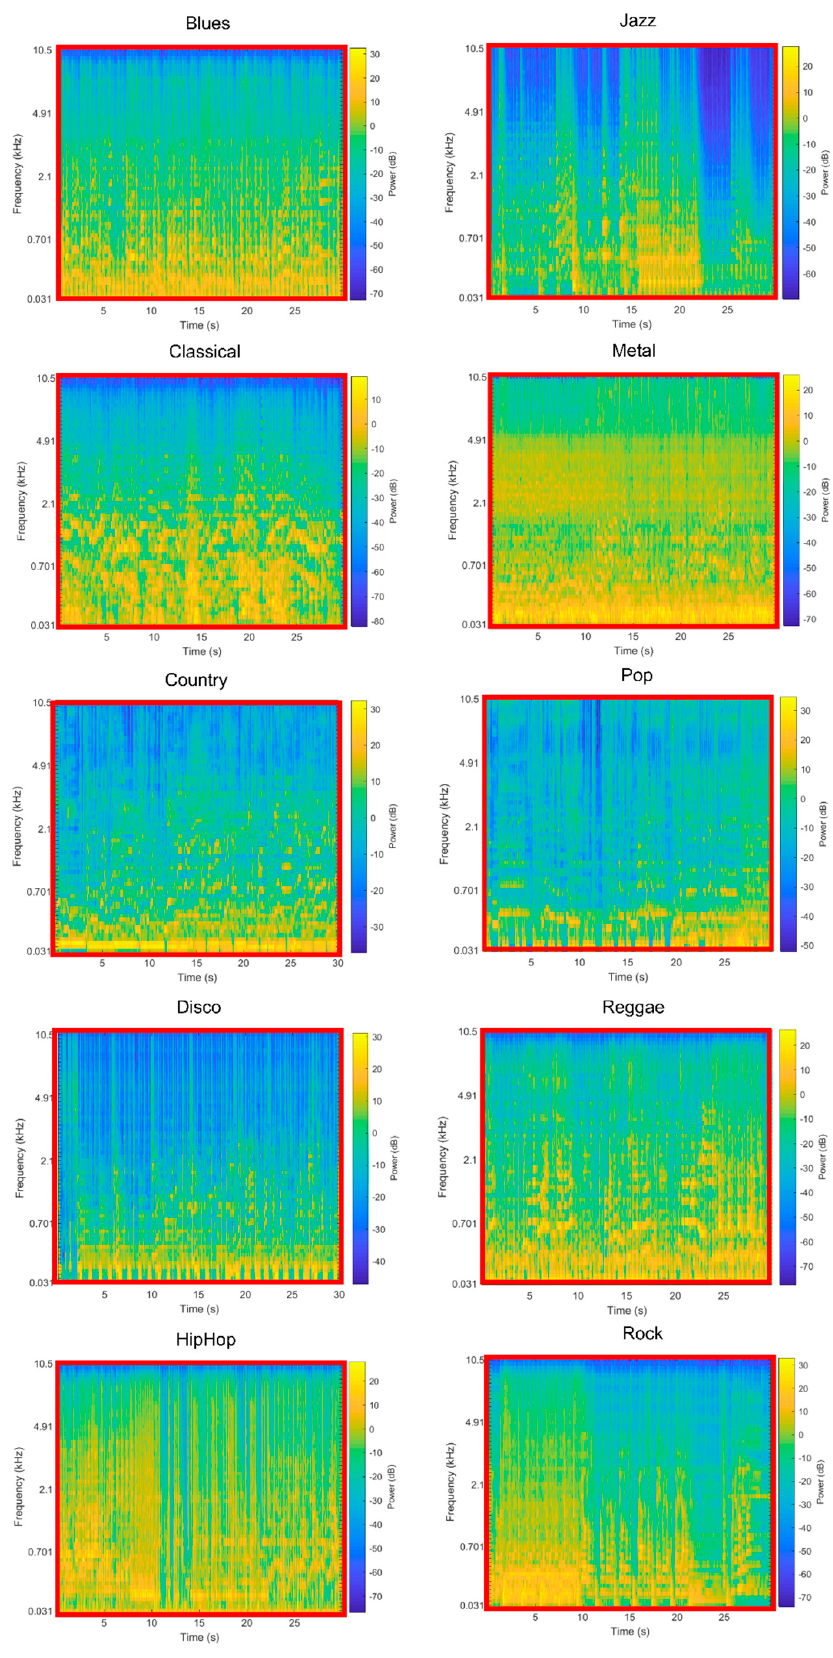
Figure 1. Construction of visual Mel spectrum.